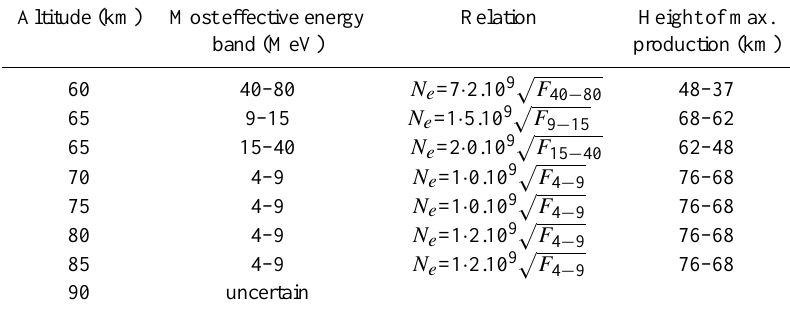
Table 1. Relations between flux F(cm − 3 s − 1 sr − 1 ) in the most effective energy band and the electron density N e (cm − 3 ) at selected altitudes.